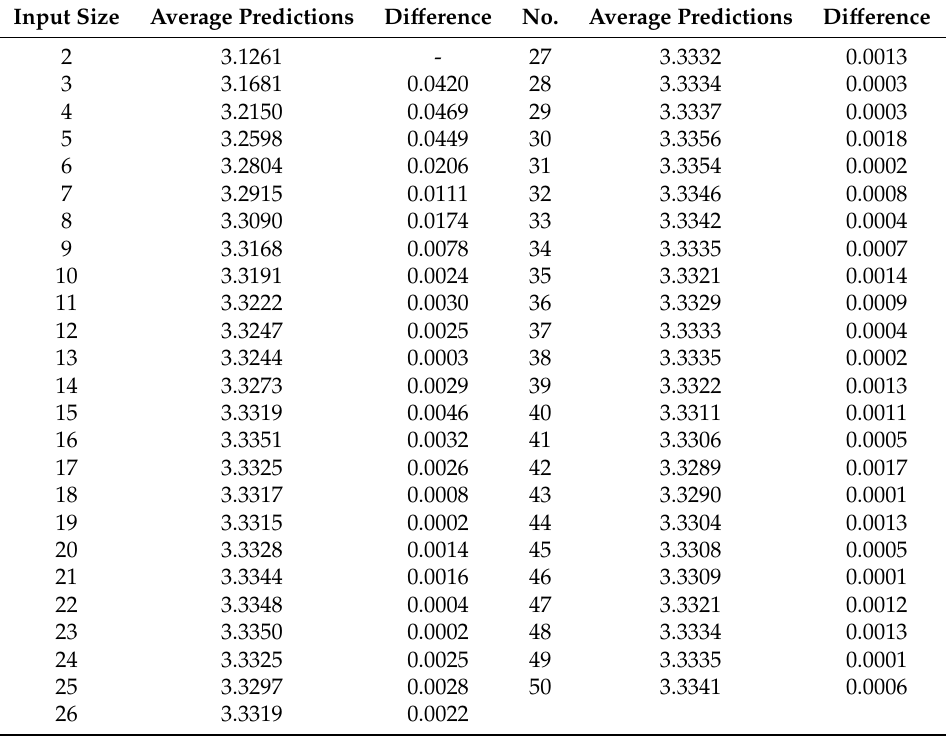
Figure 14. Size of similar user group according to the different numbers of ratings based on the cosine similarity. Table 8. Changing average of prediction and difference for each range (the item-based filtering: the cosine similarity).